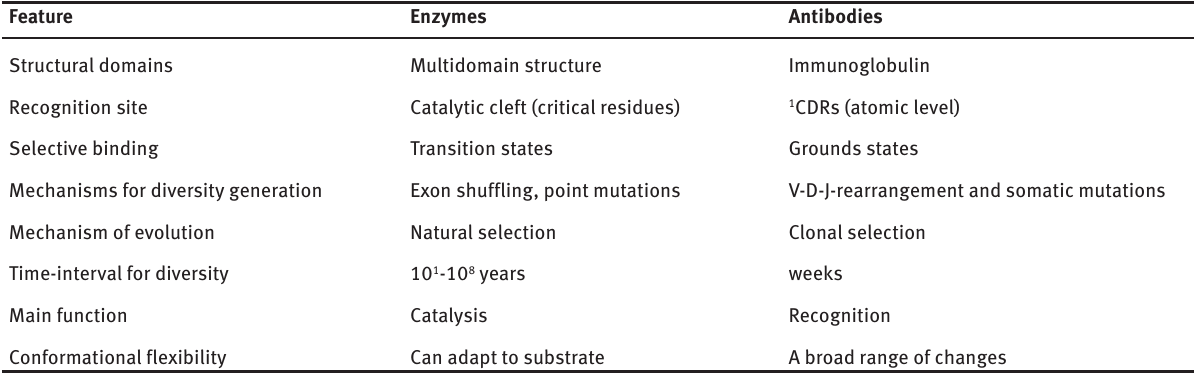
Table 2 : Differences and similarities between enzymes and antibodies.